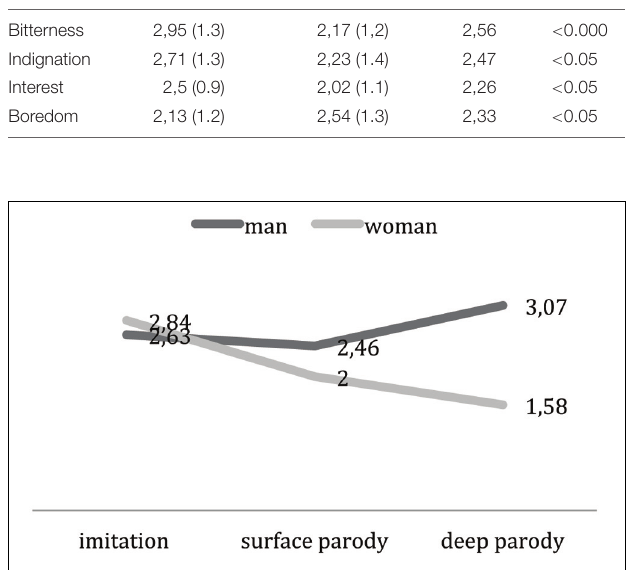
FIGURE 5 | Type of parody ∗ Parodied politician’s gender on Indignation.